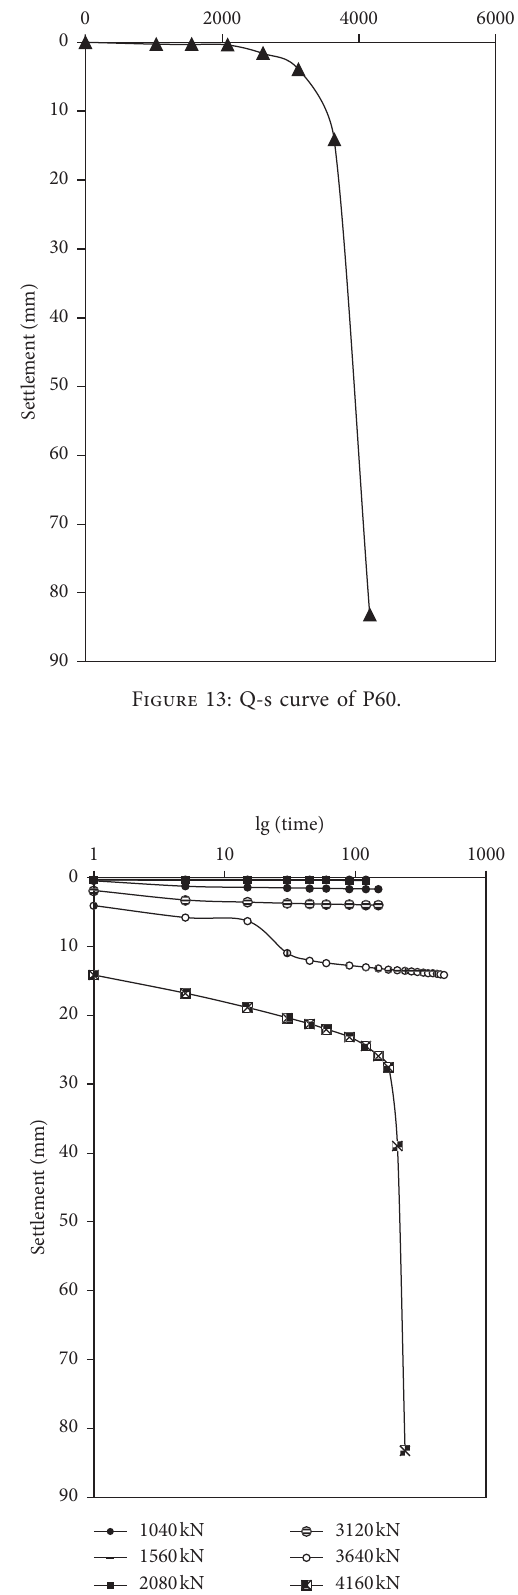
Figure 14: s-lgt curve of P60.